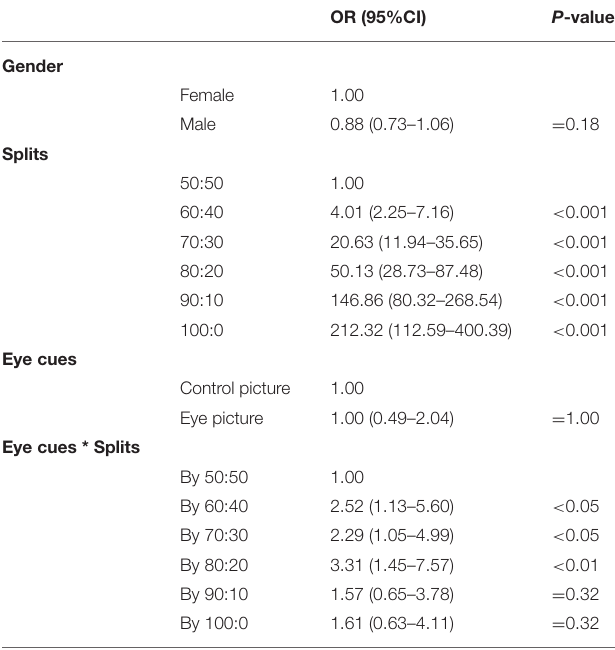
TABLE 1 | The logistic regressions analysis of punishments in Experiment